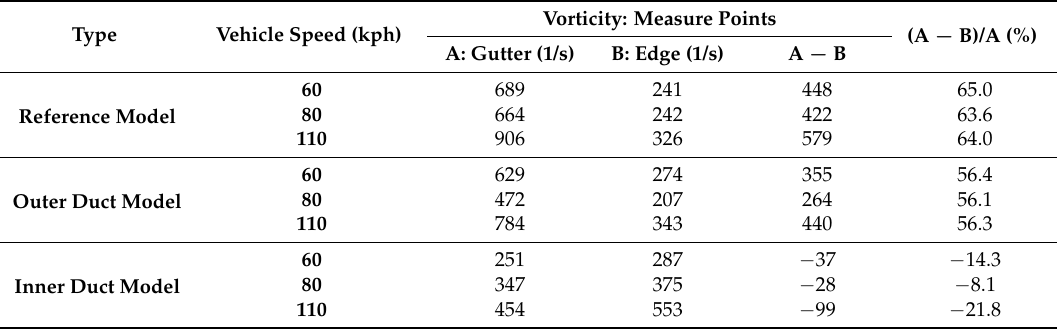
Table 3. Simulation results of vorticities according to vehicle driving speed between the gutter and the outside edge of the three OSRVM